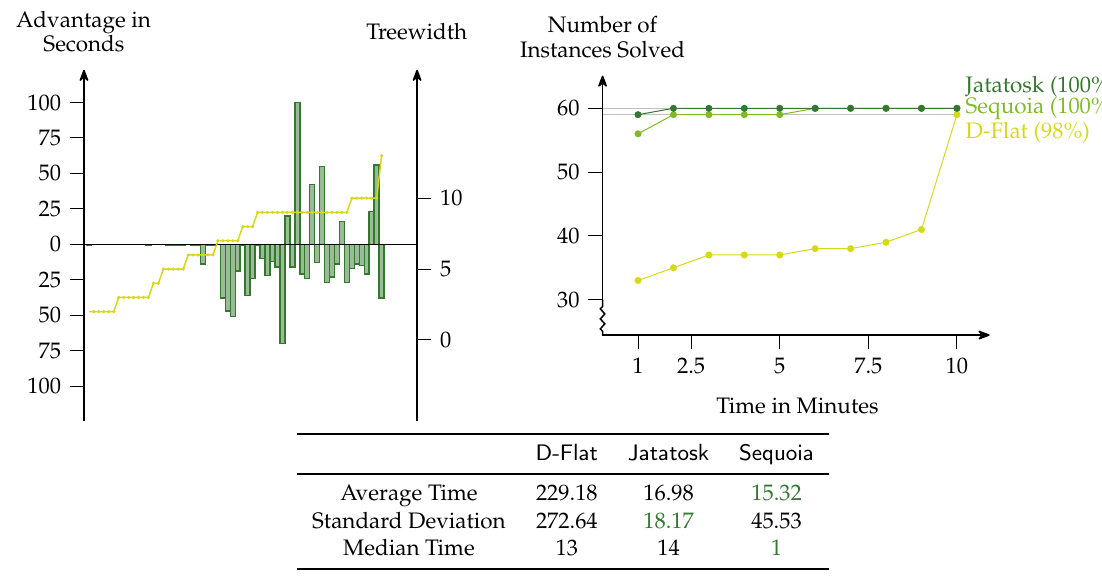
Figure 5. Experiment for the INDEPENDENT - SET